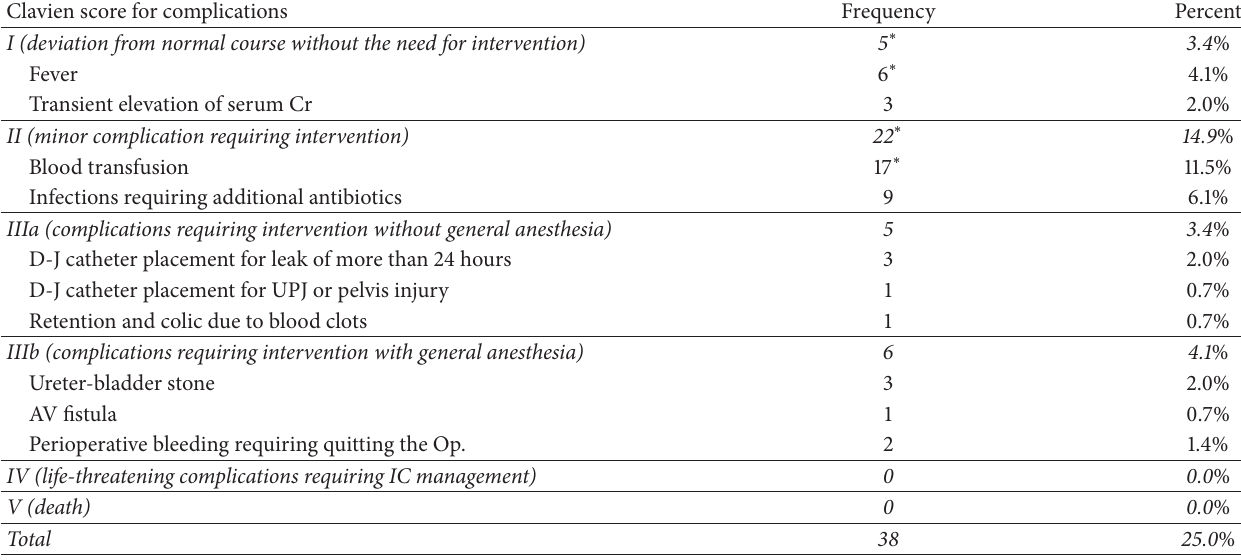
Table 5: Rate of complications including 140 successful and 8 failed